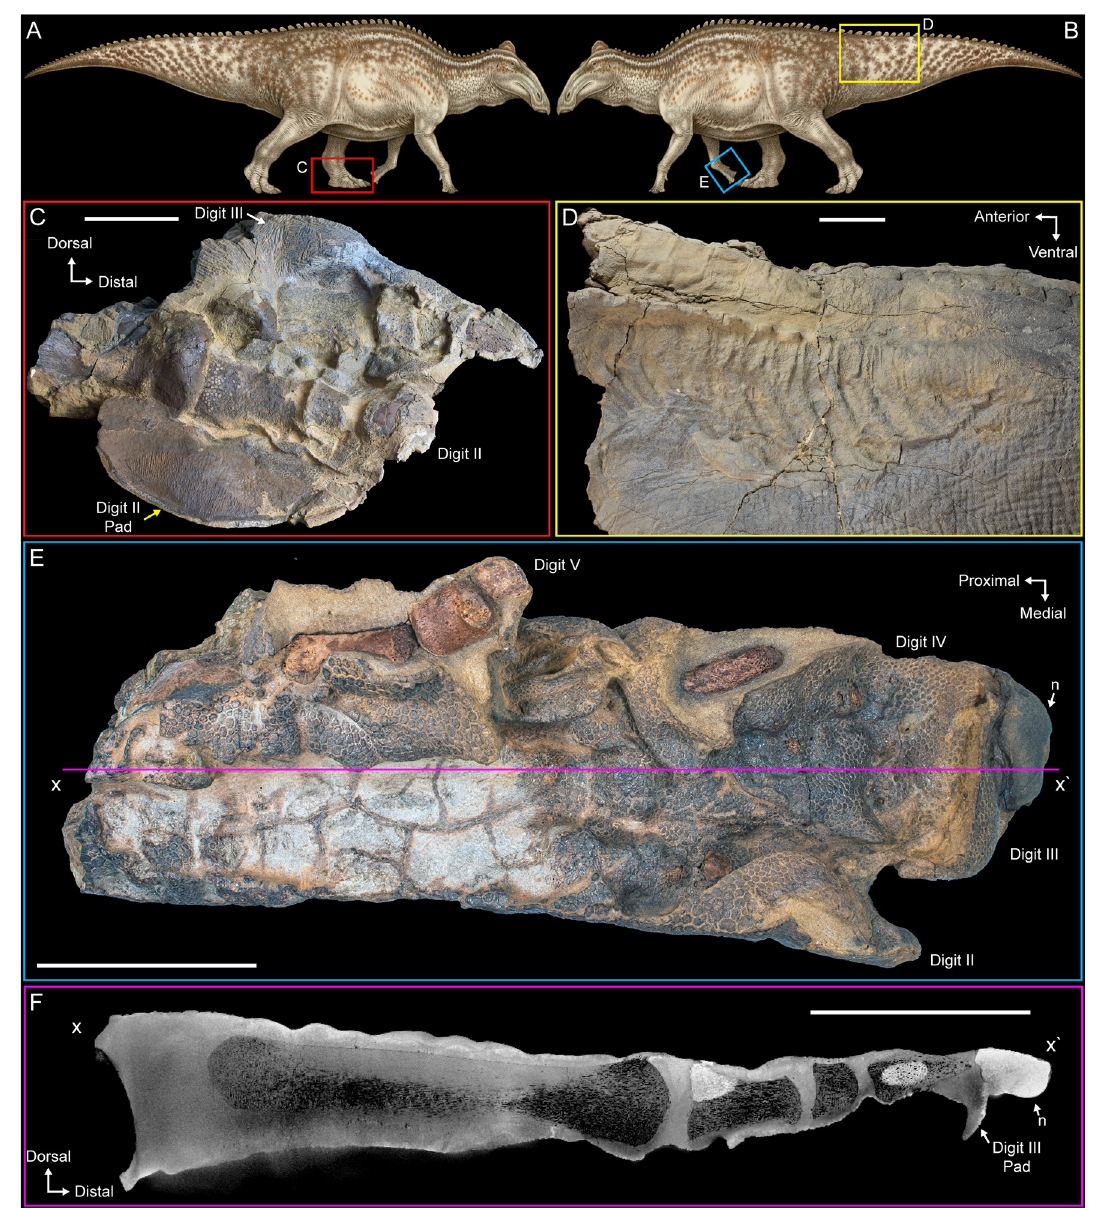
Fig 3. Evidence of desiccation in NDGS 2000. (A) NDGS 2000 reconstruction in right lateral view. (B) NDGS 2000 reconstruction in left lateral view. (C) Left pes in medial view. (D) left lateral view of the proximal portion of the tail. (E) Right manus in ventral view. (F) CT image of cross section of right manus along line x to x’ in (E). Colored boxes and lines in (A), (B), and (E) indicate the locations and views of the photographs in the other figure parts. Paleoart in (A) and (B) by Natee Puttapipat. All scale bars equal 10 cm. Abbreviations: n, iron oxide